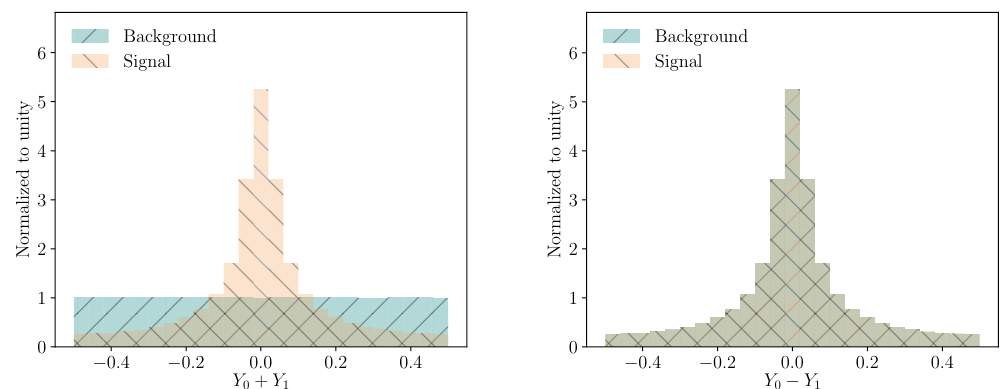
+ Y − Y (left) and Y (right). As the true signal is 0 1 0 1 + Y − Y for the signal is the same as Y for both signal 0 1 0 1